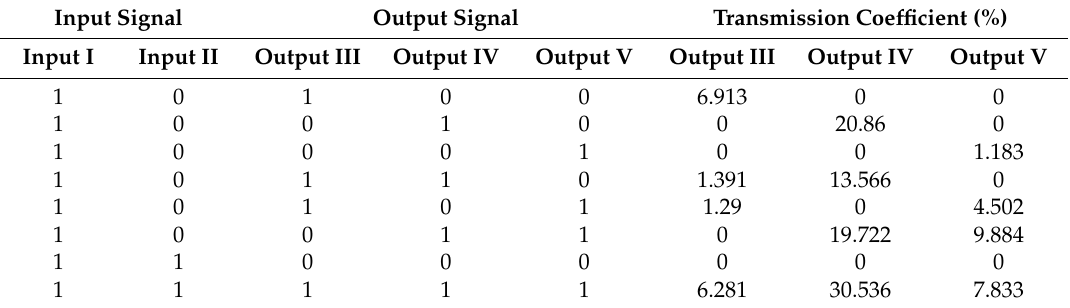
Table 4. Transmission coefficients of the two-input three-output switch at different logical states.